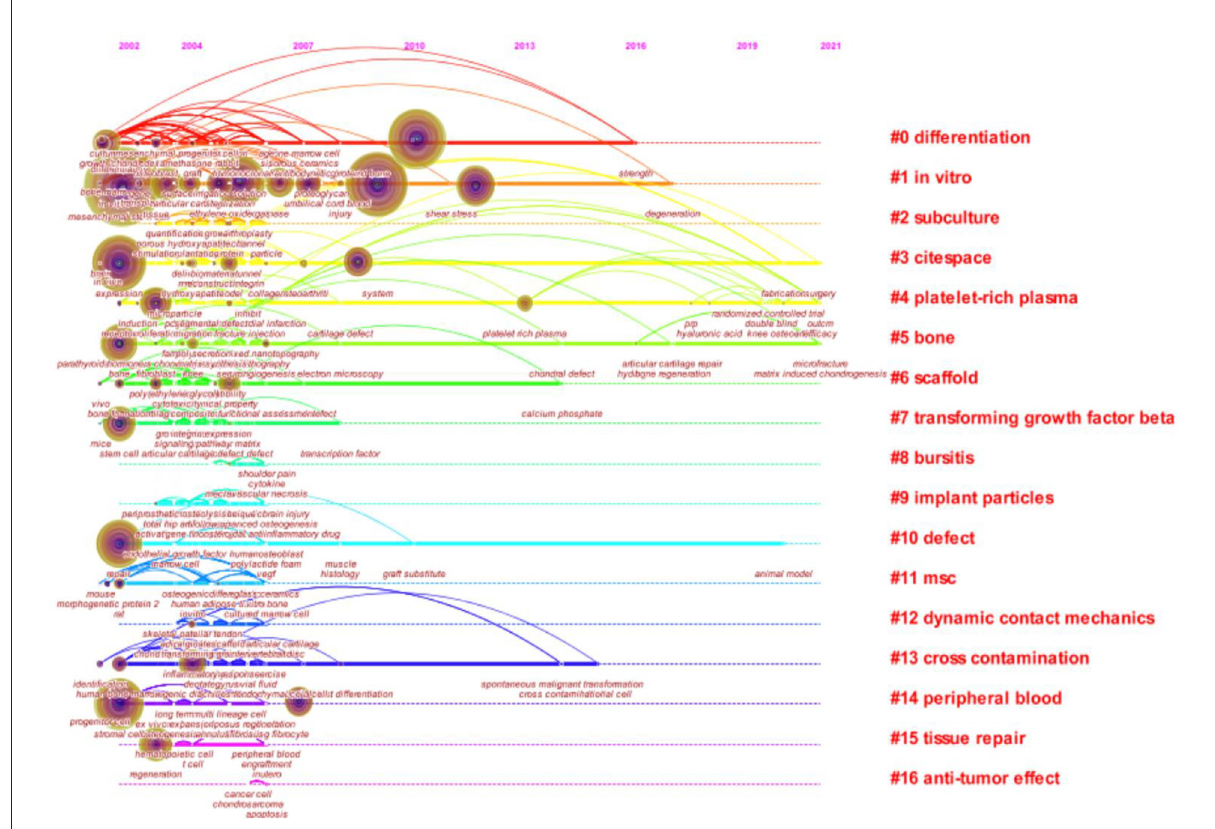
FIGURE8 Keyword timeline visualization related to MSCs in orthopedics from 2002–2021. Abscissa x is the year of publication, and ordinate y is the cluster number. The more literatures the cluster contains, the more important the cluster is in the domain. The longer the time span, the earlier and longer the duration of the